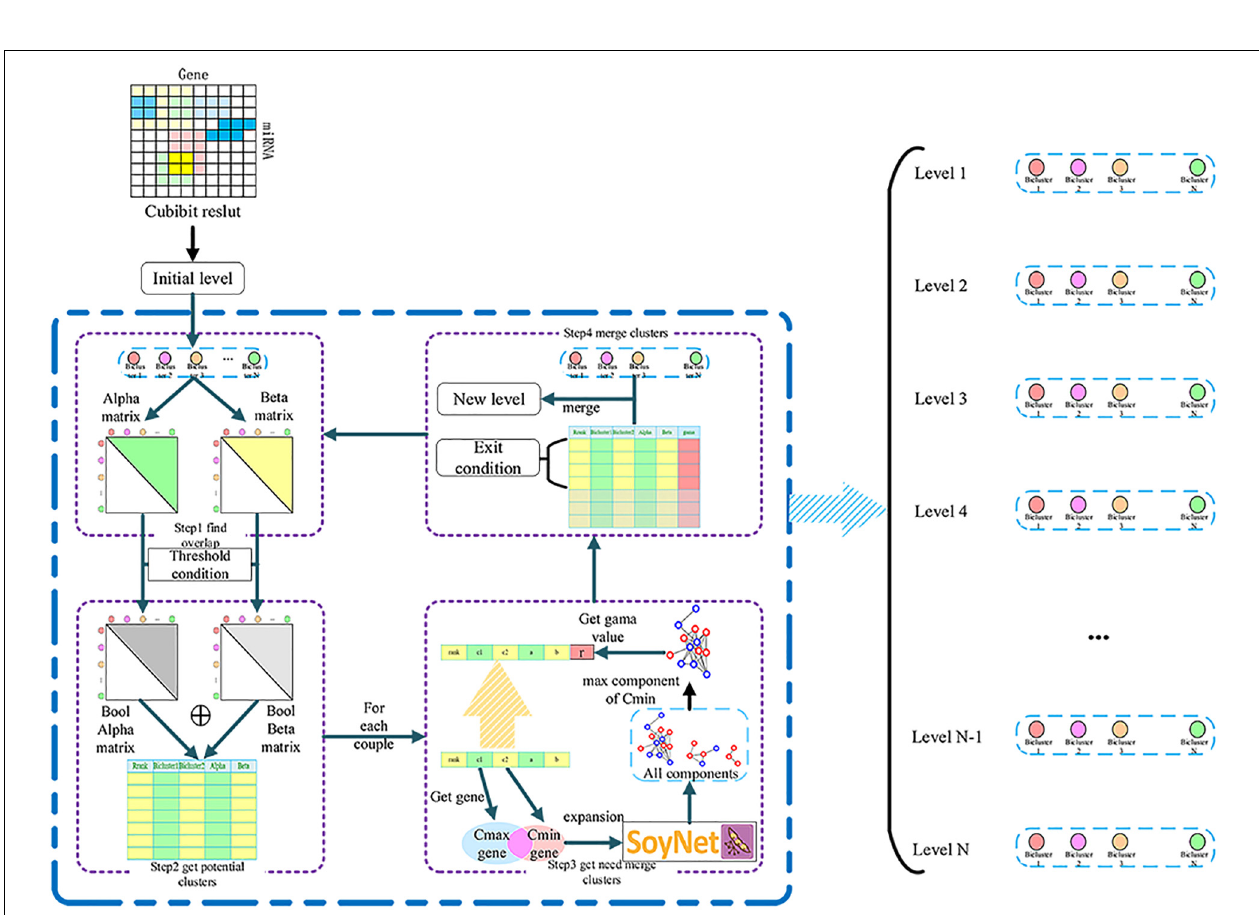
FIGURE 2 | miRNA-target regulatory modules (MTRM) iterative merge algorithm flowchart used to derive a gene interaction network.